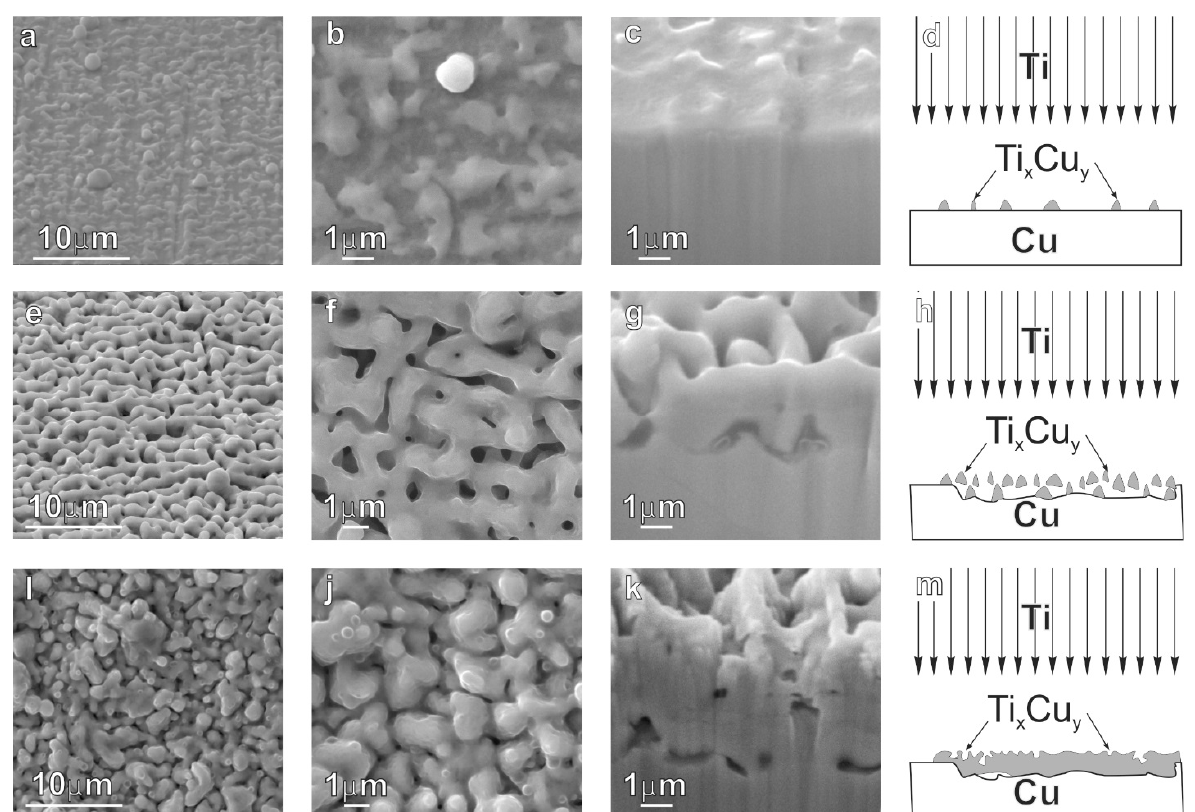
Figure 1. The surface morphology and schematic cross-section of a copper substrate after treatment with the titanium ions at different times: ( a – d ) 2 min, ( e – h ) 6 min, ( i – m ) 12 min.